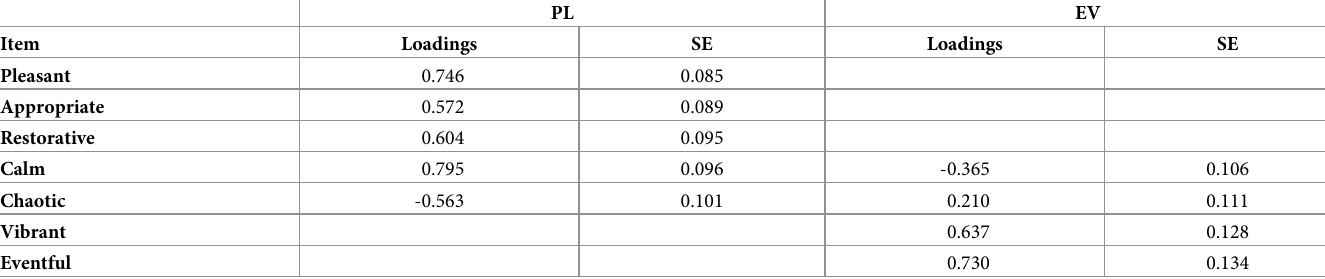
Table 4. Standardized factor loadings and standard errors (SE) for the retained CFA model for in situ data (N = 185). PL